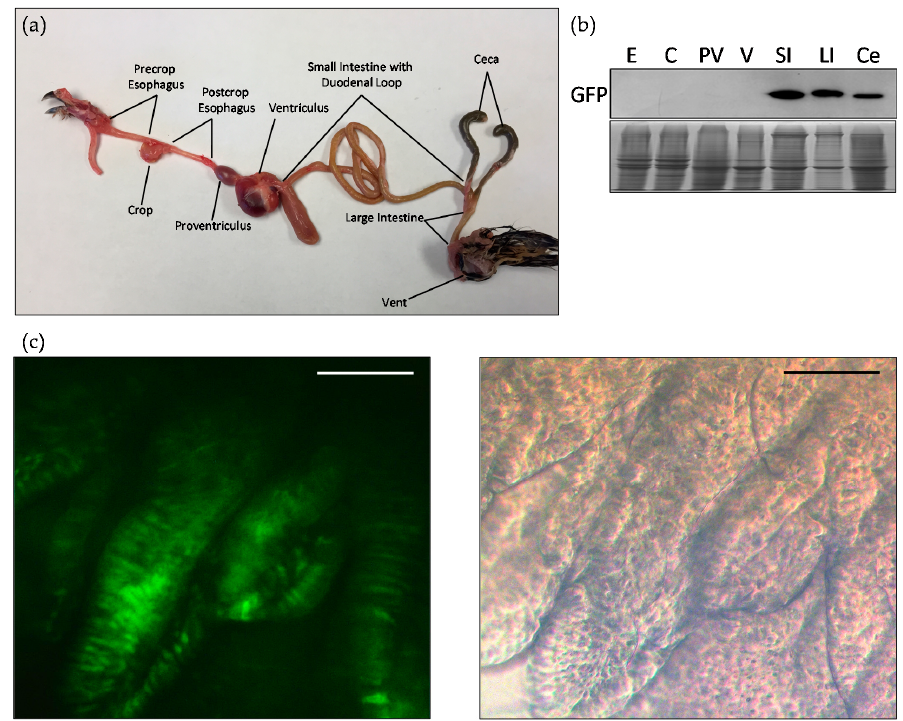
Figure 4. ( a ) Intestinal tract of Japanese quail; ( b ) Western blot analysis of transgenic quail intestinal tissue distribution including esophagus (E), crop (C), proventriculus (PV), ventriculus (V),